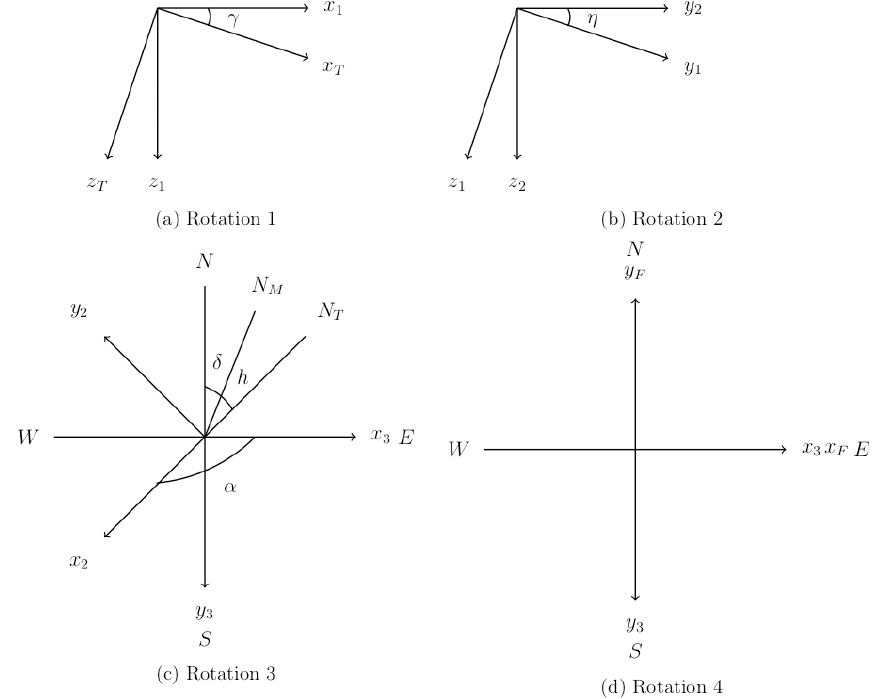
Figure 3. (a) Rotation about y T by γ = p ; figure viewed normal to the y T = y 1 axis; (b) rotation about x 1 by η = r ; figure viewed normal to the x 1 = x 2 axis; (c) rotation about z 2 by α = (δ + h + 90 ) %360; figure viewed normal to the z 2 = z 3 axis; (d) rotation about x 3 by π ; figure viewed normal to the z 3